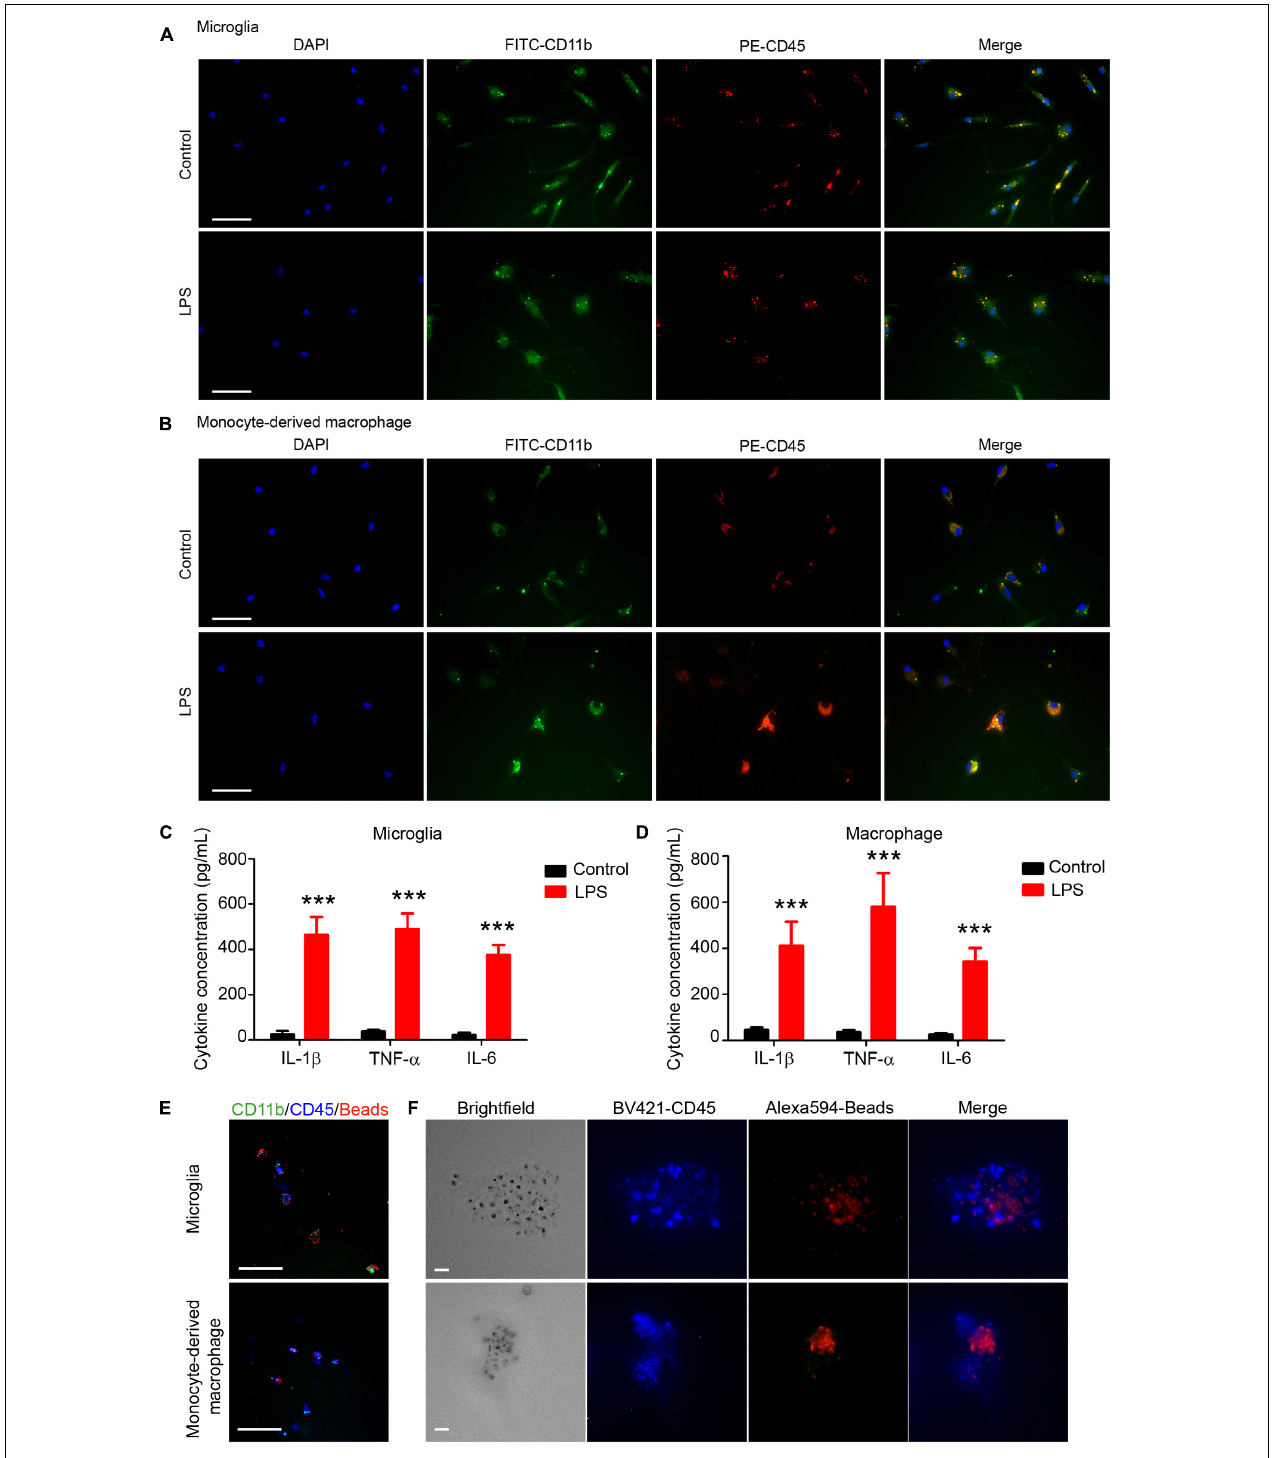
FIGURE 6 | Sorted microglia and monocytes/macrophages respond to lipopolysaccharide (LPS) stimulation and phagocytose beads ex vivo . At 1 day after mice were injected with collagenase, microglia (Ly6g − CD11b + CD45 Int PI − ) and macrophages (Ly6g − CD11b + CD45 high PI − ) were isolated, sorted, and seeded onto slides. Cells recovered briefly and were incubated with LPS or vehicle for 12 h. Representative images of (A) microglia and (B) monocyte-derived macrophages are shown. (C,D) Conditioned medium was collected and ELISA assays were performed. ∗∗∗ p < 0.001 vs. corresponding control; n = 3. Results are presented as mean ± SD. Two tailed Student’s t -test followed by Welch’s correction. (E,F) Cells were incubated with fluorescence-conjugated latex beads for 4–6 h and fixed before imaging. Representative images are shown. Scale bars: (A,B) 50 µ m; (E) 100 µ m; and (F) 10 µ m.